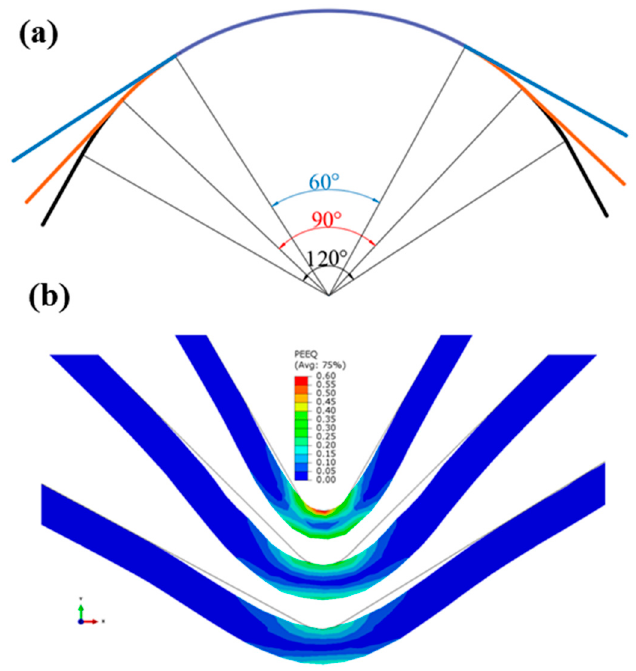
Figure 8. ( a ) Diagram of bent specimens under different bending angles and ( b ) equivalent strain distribution.